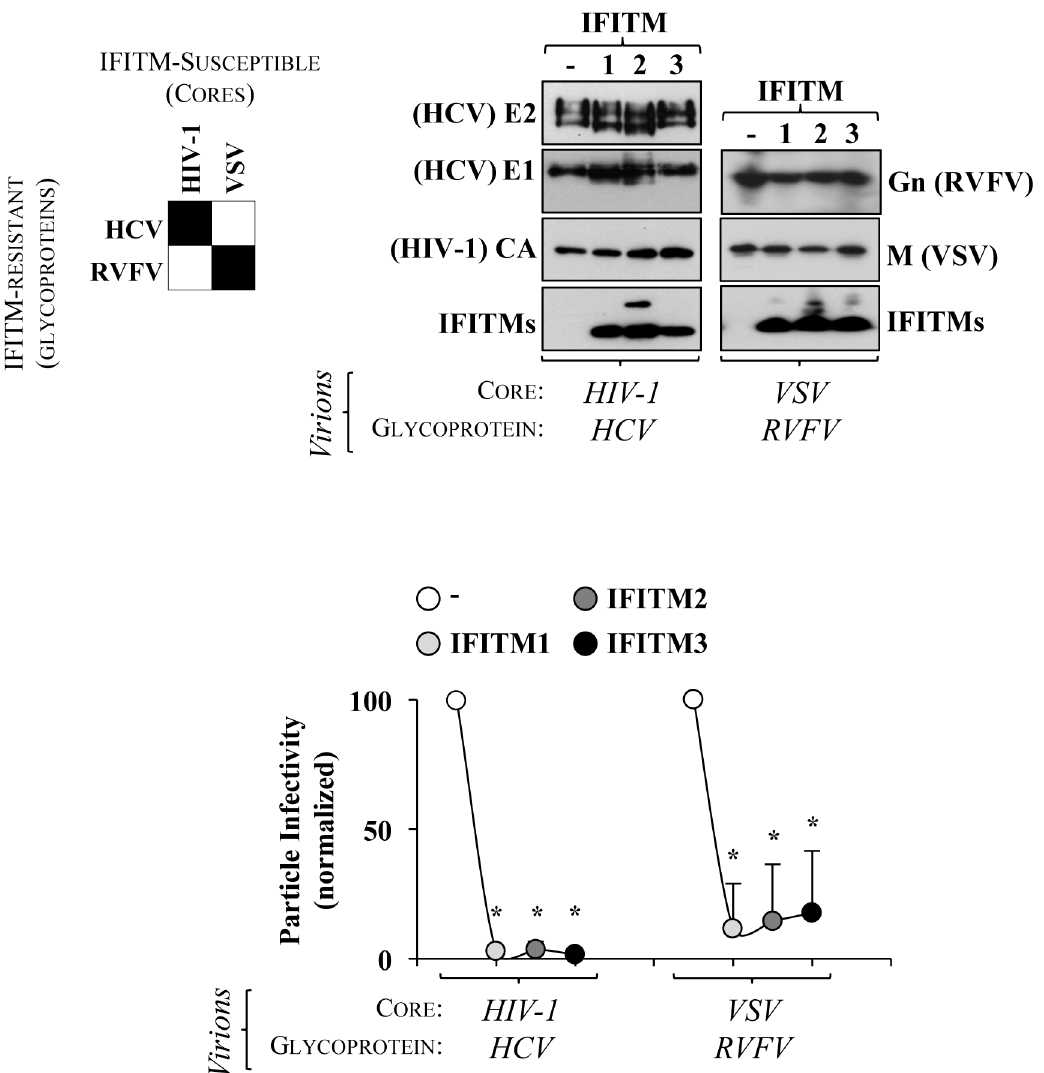
Fig 8. Genetic elements swapping indicates the mode of virion assembly as a dominant determinant in the virus susceptibility to IFITMs. Glycoproteins of IFITM-resistant viruses were used to pseudotypeviral cores of IFITM- susceptible viruses (as indicated).HIV-1 virions presenting the HCV E1/E2 glycoproteins were producedin the presence of IFITMs by co-transfection of the respectiveDNAs (1:1 ratio). VSV pseudoparticles (VSVpp) incorporating the RVFV GnGc in the presenceof IFITMs were produced in HEK293T transfected with DNAs coding for GnGc along with IFITMs (0.7:1 ratio), followingchallenge with a viral stock of Δ G-VSV virus that had been previously complemented with the G protein to allowits entry into cells. After entry, absenceof G allows the production of novel virion particles that assembled in the presenceof IFITMs and of the RVFV GnGc glycoprotein. Residualinput virus was neutralizedby incubation with an anti-G neutralizingantibody. Virion particleswere purifiedfrom the supernatantof virus-producing cells, normalized and used to challengetarget cells in a classical single round of infectionprior to flow cytometry analysis. The panels present typical results, whilethe graphs present averagesand SEM of 3 to 5 different experiments. * , p (cid:20) 0.05after a Student t test.